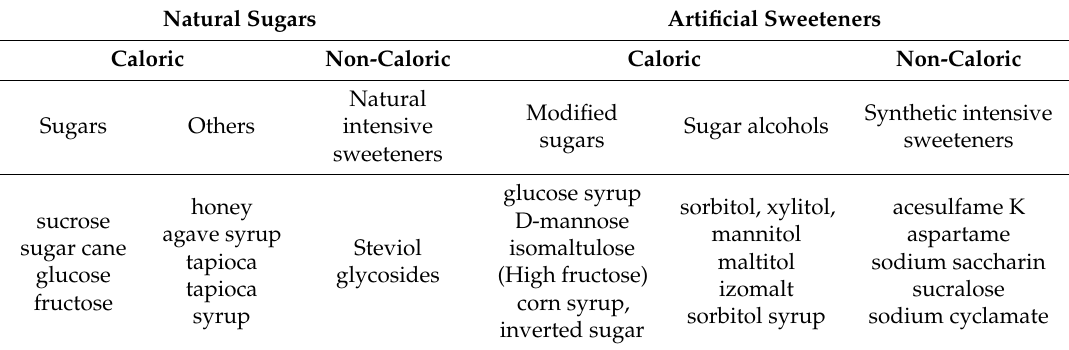
Table 1. Sweetening agents and sweeteners in analyzed group of dietary supplements.